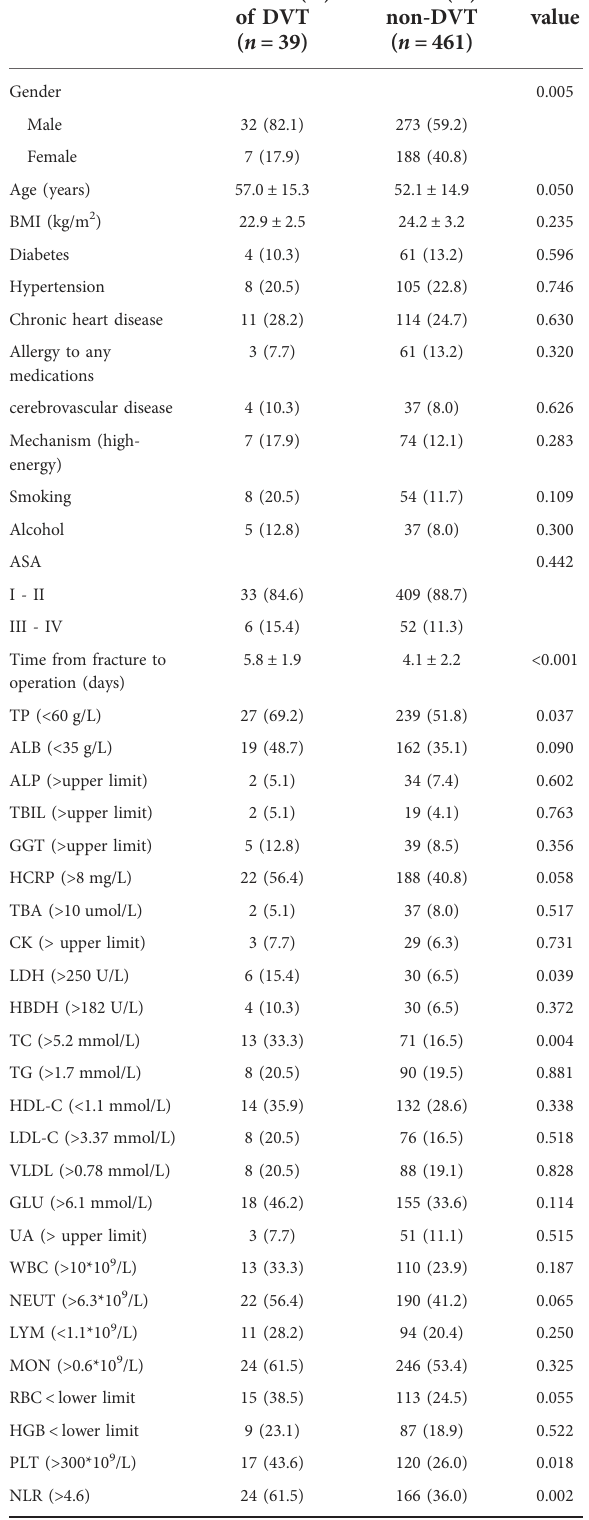
TABLE 2 Univariate analyses of risk factors associated with preoperative DVT after patella fracture.